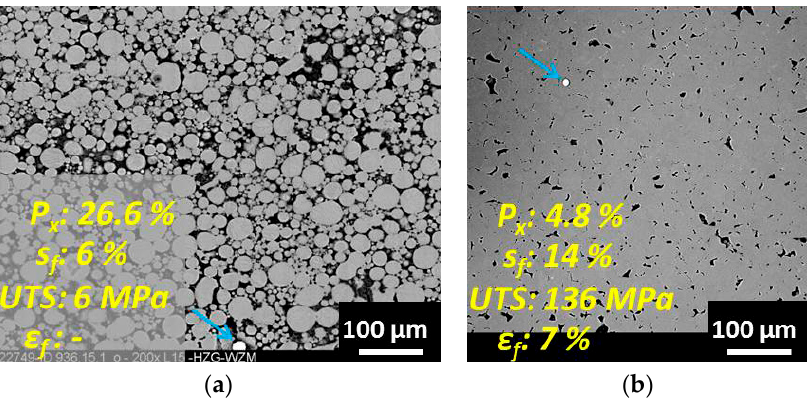
Figure 7. SEM micrographs of thermal debound and sintered MIM specimens after 64 h sintering time using PE ‐ VA copolymer ( a ), and PPcoPE copolymer ( b ) showing residual porosity P x , shrinkage s f , UTS and elongation at fracture ε f as a function of the used backbone polymer. The blue arrows assign the presence of minor titanium contamination as described in paragraph 3.3 and displayed in Figure 6.